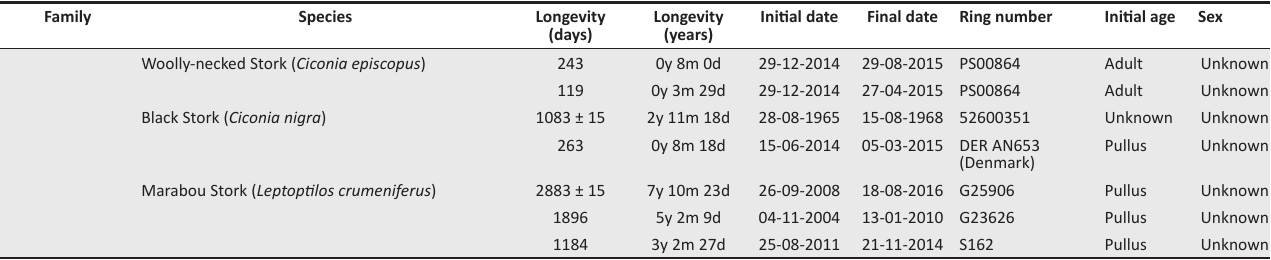
TABLE 1-A2 (Continues...): Top three longevity records of southern African Ardeidae, Threskiornithidae and Ciconiidae species from ringing records at the South African Ringing Scheme. Family Woolly-necked Stork ( Ciconia episcopus